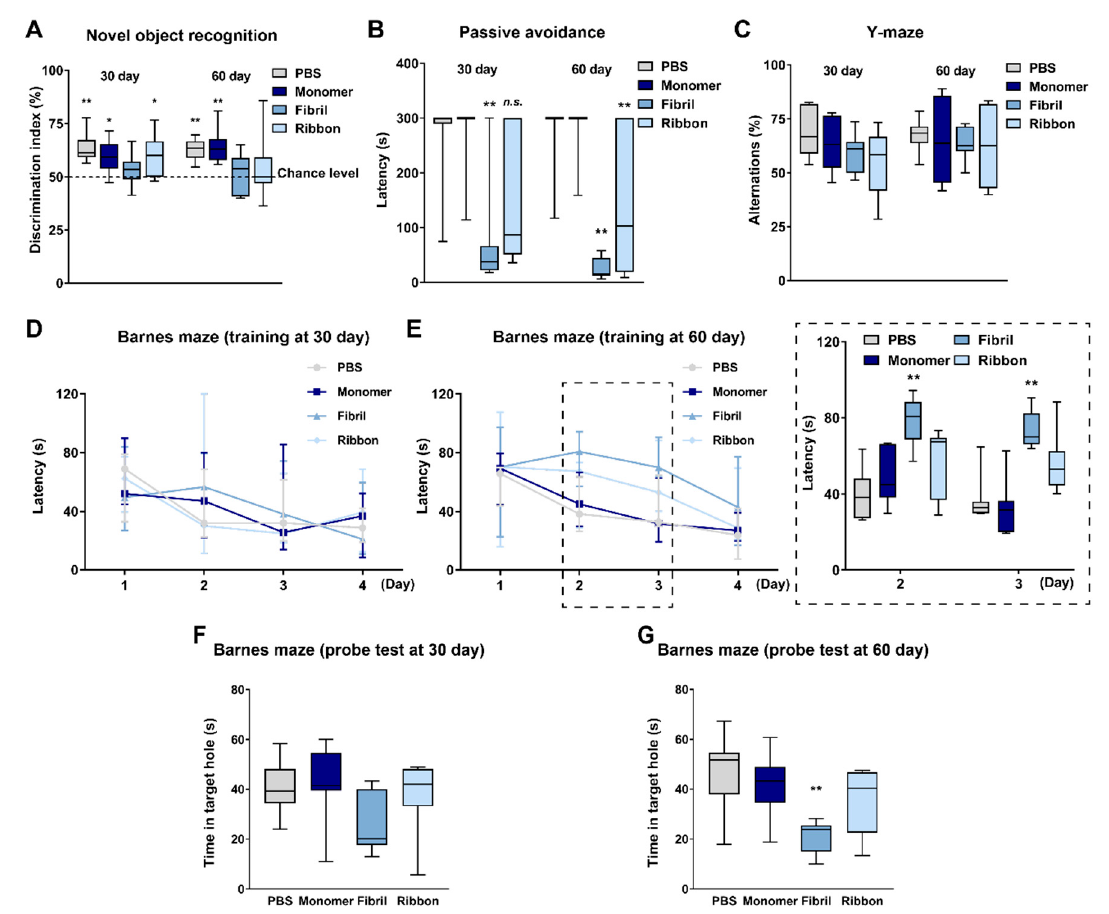
Figure 2. α Syn strain-dependent cognitive impairments in intrastriatally injected mice. ( A ) Discrimination index in a novel object recognition task ( n = 7 per group). * p < 0.05 and ** p < 0.01 between contacts with familiar and novel objects within groups. ( B ) Latency to enter the dark compartment in a passive avoidance task ( n = 7 per group). ** p < 0.01 vs. PBS-injected group in the same day. n.s., not significant. ( C ) Spontaneous alternations in a Y-maze task ( n = 7 per group). ( D , E ) Latency to enter the escape box in training sessions in a Barnes maze task ( n = 7 per group). The sessions were conducted twice per day. The insertion depicts the days when the latency was significantly different between groups. ** p < 0.01 vs. PBS-injected group. ( F , G ) Latency to explore the target hole in probe test sessions in the Barnes maze task ( n = 7 per group). The test was conducted 7 days after the first training sessions. ** p < 0.01 vs. PBS-injected group.